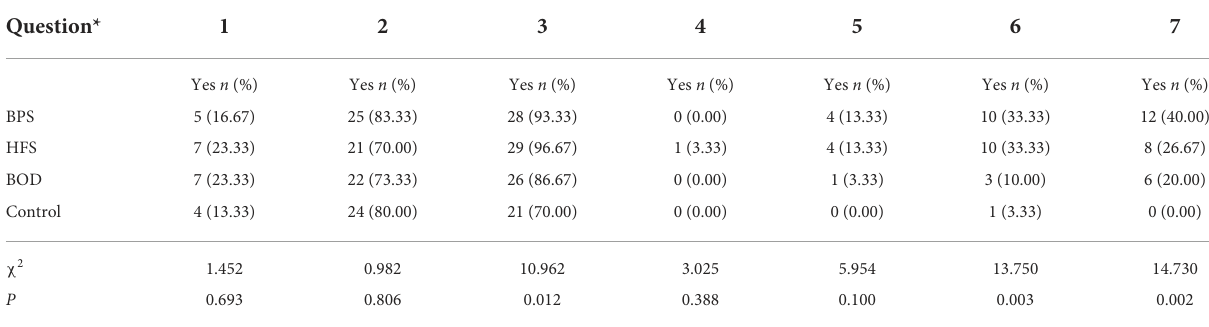
TABLE 3 Stigma comparisons [ n